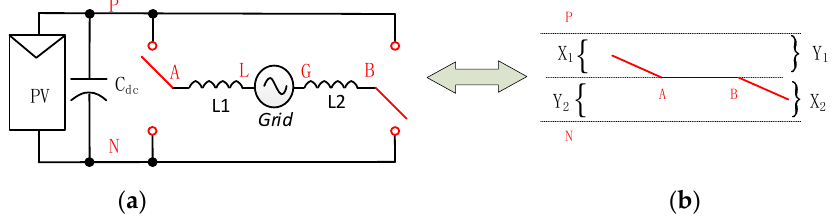
Figure 4. ( a ) Full-bridge topology; ( b ) Simplified schematic diagram of full-bridge topology.